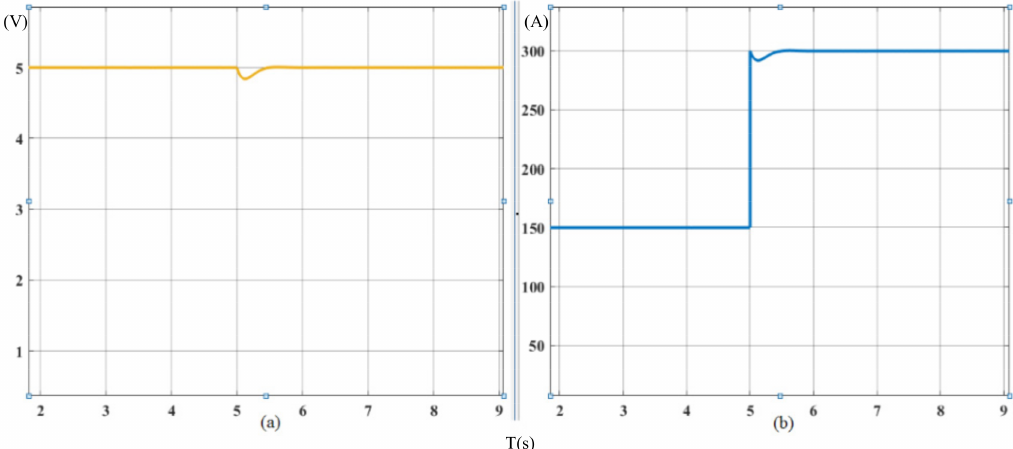
Figure 15. DC output waveforms controlled by the nonlinear feed-forward PID control when the load suddenly increases: ( a ) voltage waveform; ( b ) current waveform.